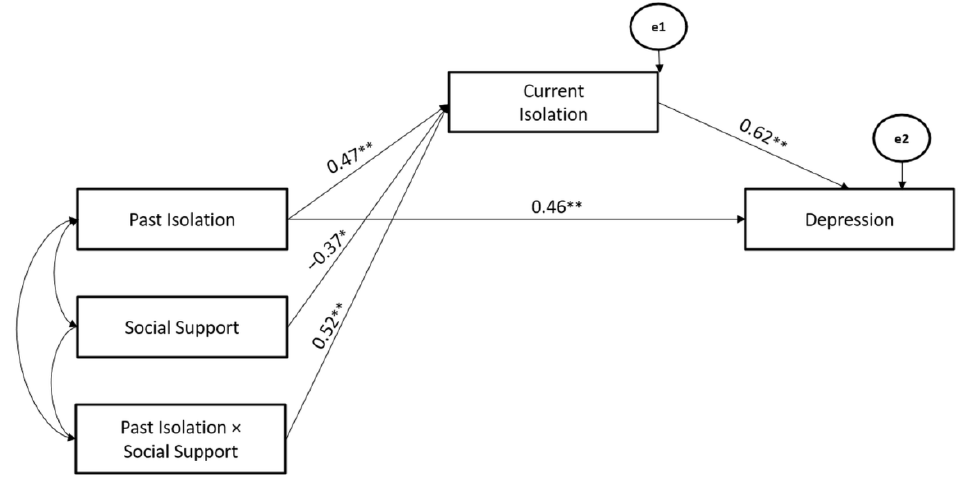
Figure 6. The Mediated-Moderated model of Past and Current Isolation stressors, Social Support Coping Strategy, and Depression. ** p < 0.01; * p < 0.05.